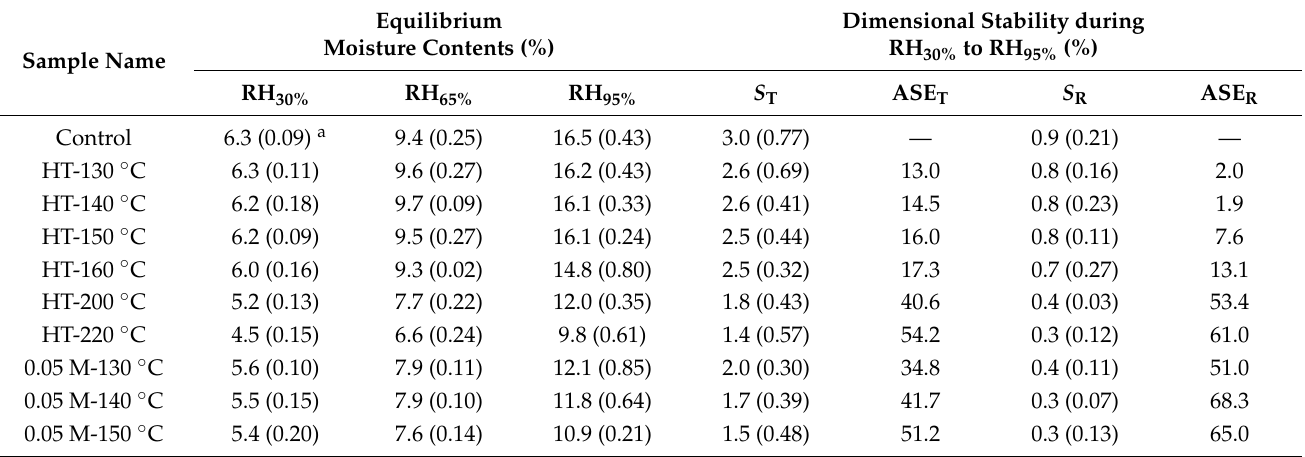
Table 1. EMC, S values, and ASE values in tangential and radial directions of untreated and treated samples in different